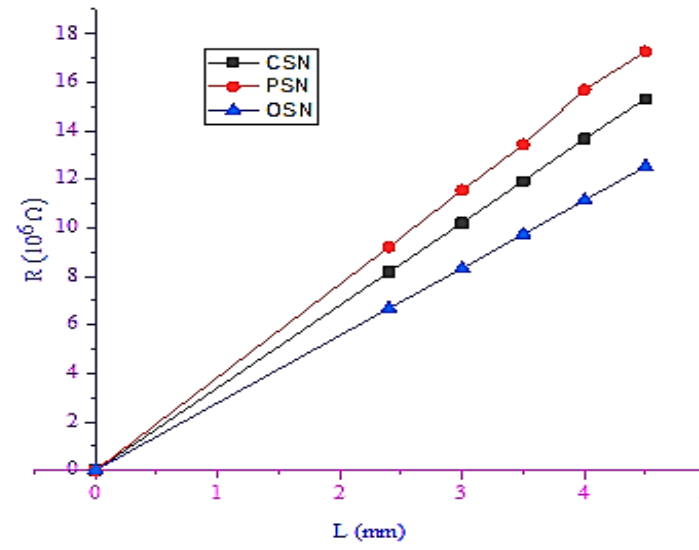
Figure 3. Variation of electrical resistance depending on samples’ length.